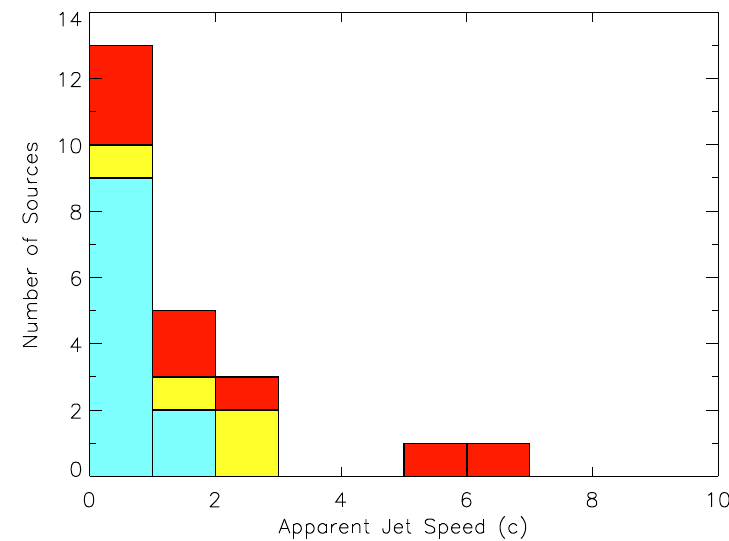
Figure 2. A histogram of the peak jet speeds in TeV blazars. Blue denotes sources from our previously published data, red are from this work, and yellow are from MOJAVE. The highest apparent speed are observed in RBS 0413, (6.0 ± 1.2) c , and RGB J0710+591, (5.8 ± 1.5) c